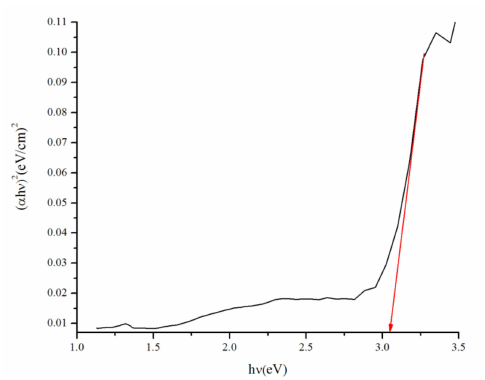
Figure 8. Tauc Plot for 10%TiO 2 /SBA15